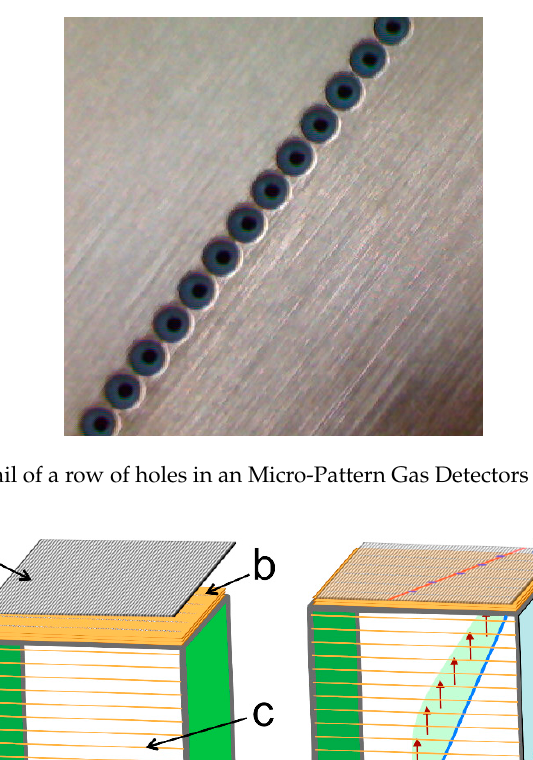
Figure 7. Detail of a row of holes in an Micro-Pattern Gas Detectors (MPGD) plane. Figure 6. Left : 3D drawing of the robotic arm while extracting a target through the suitable vacuum valve. Right : placement of the target on the parking rack outside the scattering chamber.